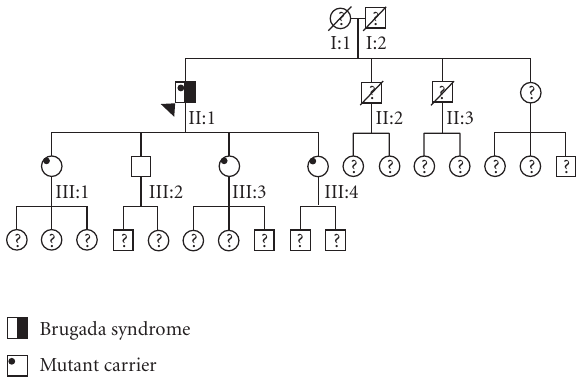
Figure 1: ECG (paper speed 25mm/s) taken just after the patient was resuscitated. Notice the type-1 BrS configuration in V 1 (upper arrow) and the type 2 configuration in V 2 (lower arrow). All recordings were taken from the same ECG.